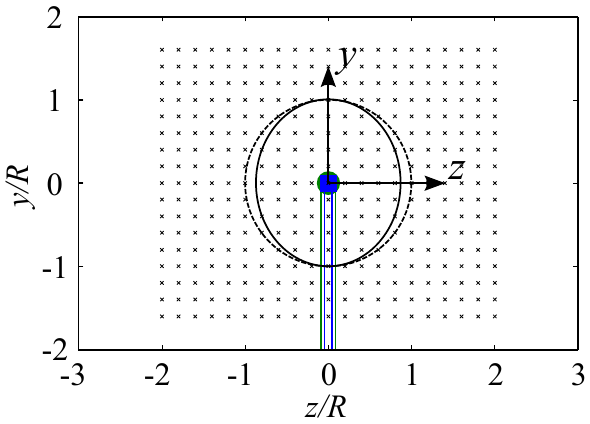
Figure 5. Measurement grid in the wake consisting of 357 points, the blue tower and nacelle represents the NTNU turbine LARS1, the green tower and nacelle represents the ForWind turbine, the dashed line corresponds to the projection of the rotor diameter γ = 0 ◦ , the solid line corresponds to the projection of the rotor area γ = 30 ◦ , and the outline corresponds to the cross section of the wind tunnel with the NTNU turbine